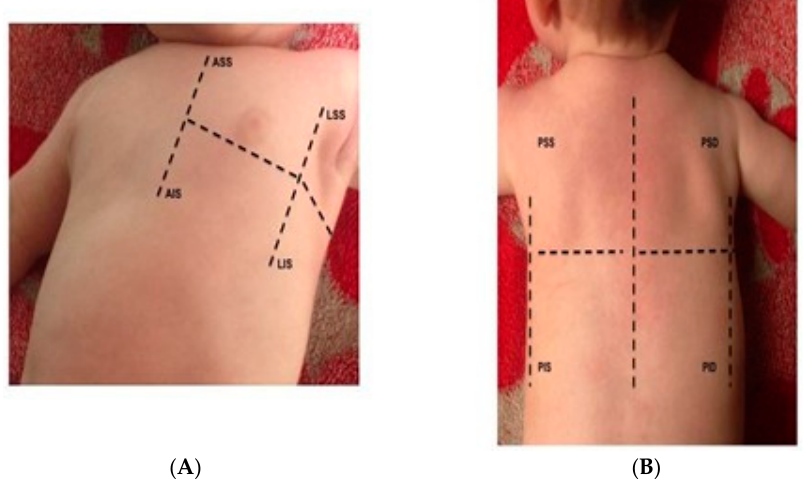
Figure 1. Six segments score. Each hemithorax is divided into 3 major quadrants (anterior, lateral, and posterior). Each quadrant is further subdivided into the upper and the lower half. ( A ) anterior and lateral, ( B ) posterior quadrants.